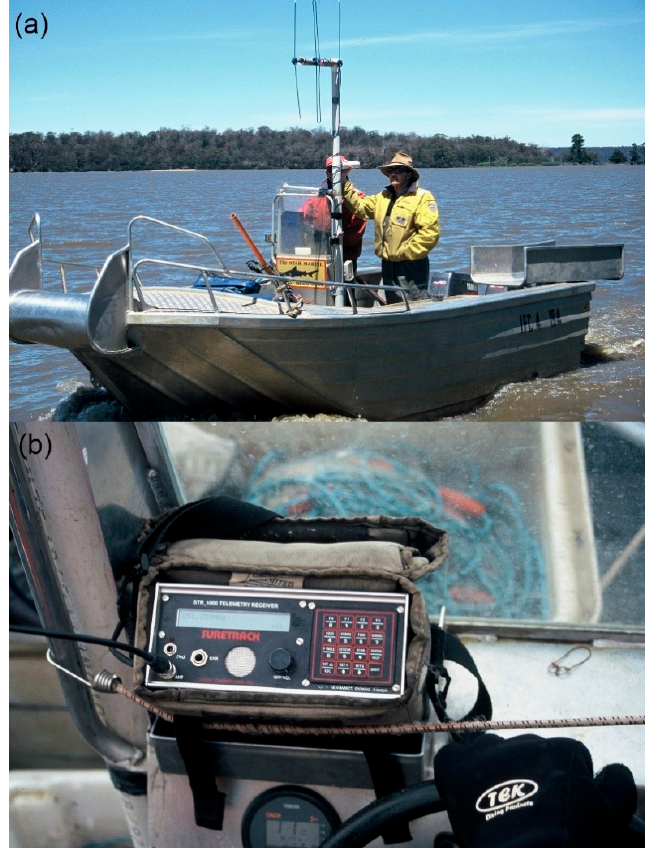
Figure 3. A CMP work boat with a directional antenna installed ( a ), hooked up to a Lotek telemetry receiver ( b ) for tracking and monitoring transmitter carp.